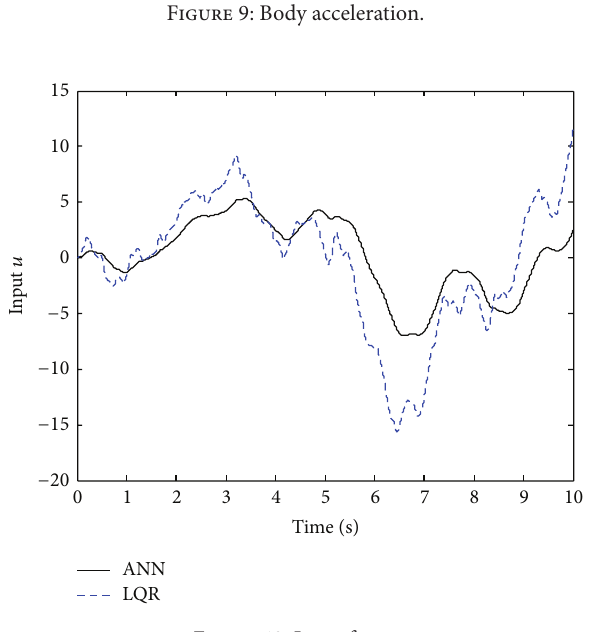
Figure 10: Input